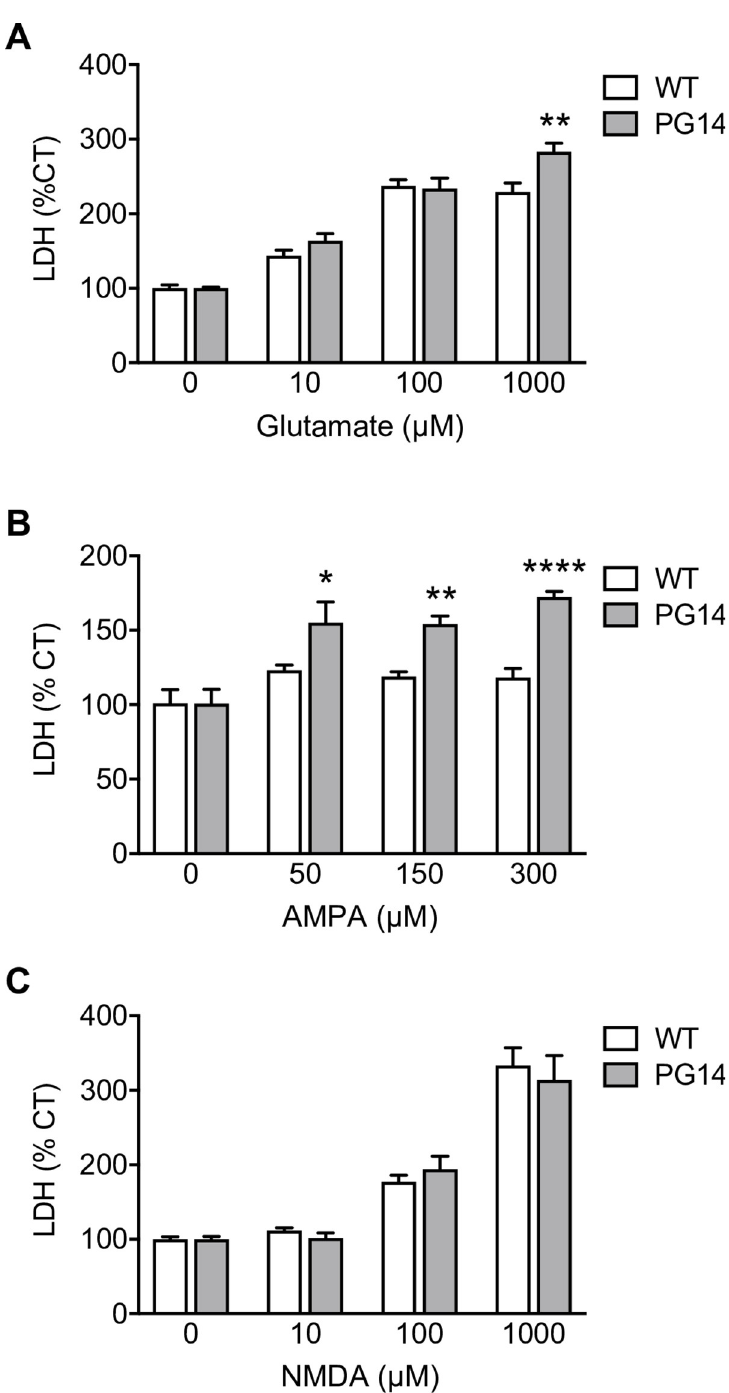
Fig 7. PG14 CGNs are hypersensitive to glutamate- and AMPA- but not NMDA-induced excitotoxicity. CGNs from WT and PG14 mice were treated with glutamate (A), AMPA (B) or NMDA (C) at the concentrations indicated. After 24h cell death was quantified by LDH assay, and expressed as a percentage of the values for cells treated with the vehicle. Data are the mean ± SEM of 6–11 replicates from three independent experiments; � p < 0.05, �� p < 0.01, ���� p < 0.0001 by two-way ANOVA, Bonferroni’s post-hoc test.